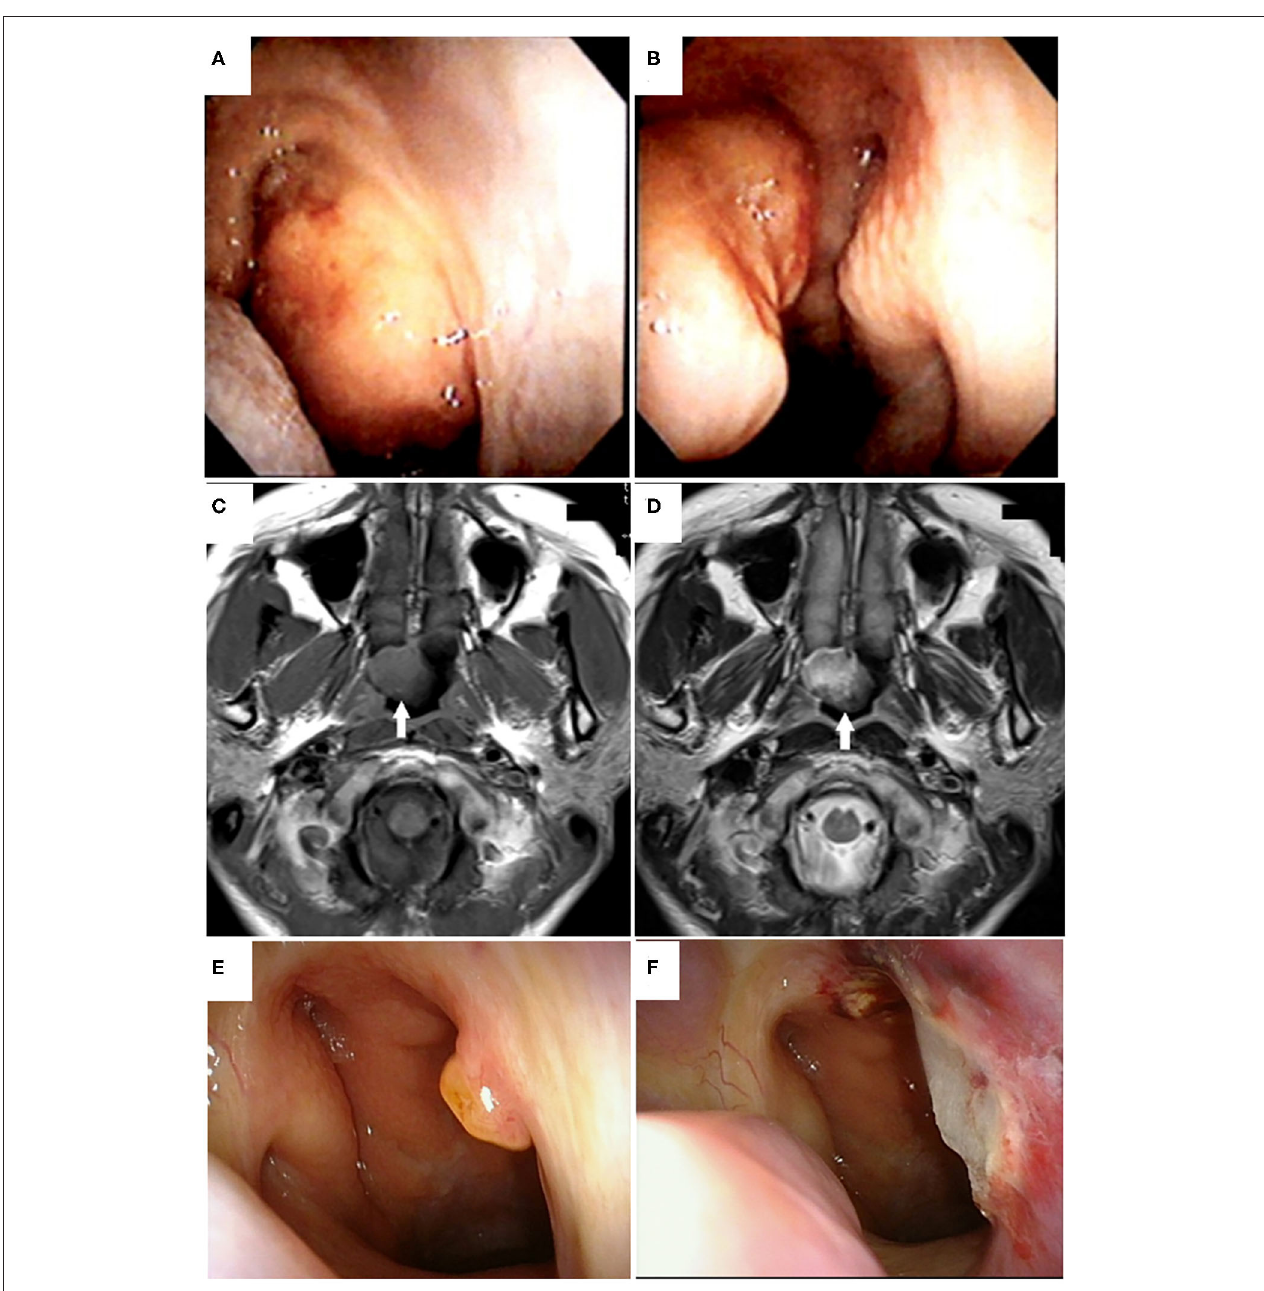
FIGURE 1 | Tumor appearance on nasopharyngeal endoscopy and magnetic resonance imaging (MRI). Endoscopic findings of the nasopharyngeal tumor viewed from the right (A) and left (B) nasal cavities at the first visit to the previous hospital are shown. A pedunculated polypoid tumor originating from the posterior edge of the nasal septum was found in the epipharynx. Horizontal views of plain T1-weighted (C) and T2-weighted magnetic resonance imaging (D) of the head showed a tumor of ∼ 20mm in diameter located in the epipharynx originating from the posterior edge of the nasal septum without invasive or destructive findings (white arrows). T1- and T2-weighted images showed the same or slightly higher intensities compared to that of the nasal concha. Preoperative (E) and postoperative (F) endoscopic findings of the nasopharyngeal tumor viewed from the right nasal cavity in our hospital. In the preoperative view, the main portion of tumor had disappeared and only the pedunculated portion remained (E) . The tumor was endoscopically resected with a 5-mm safety margin (F) .